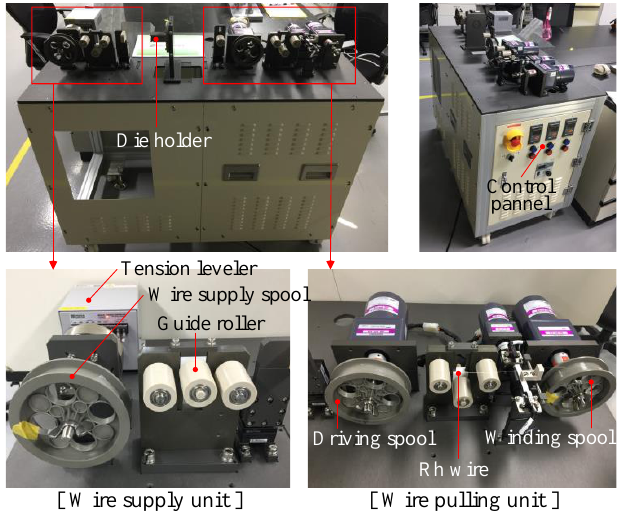
Figure 7. Precision fine wire drawing machine.